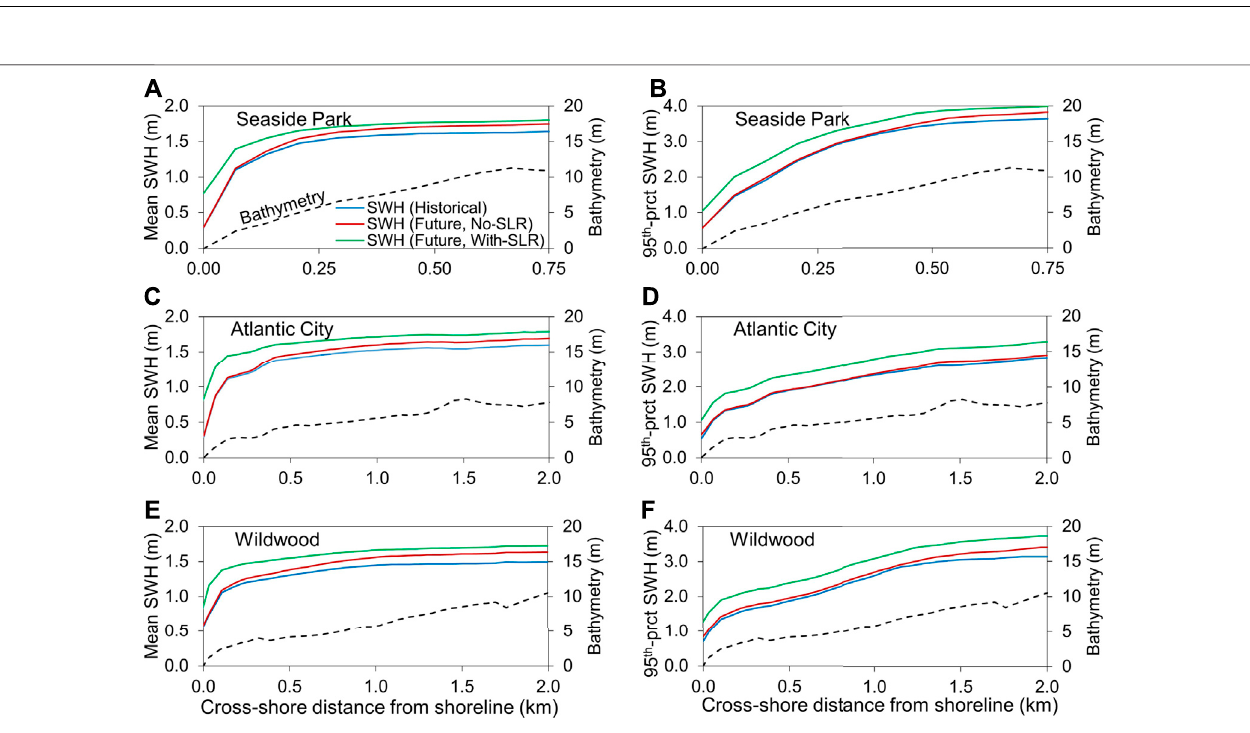
Frontiers in Built Environment |